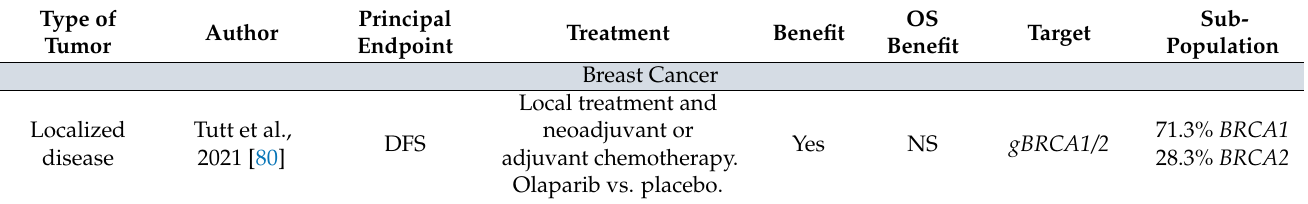
Table 2. Phase III trials with PARP